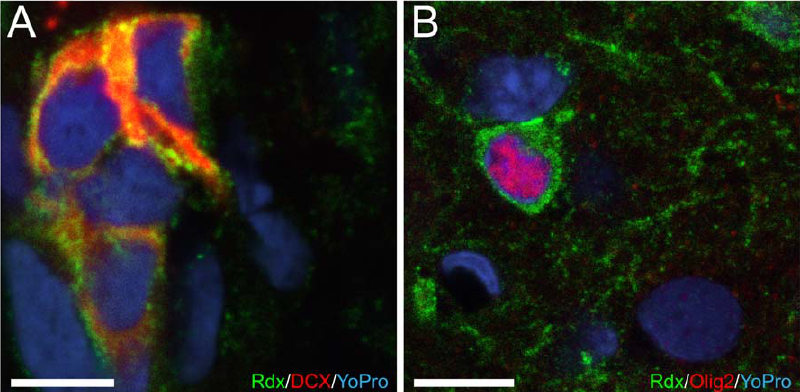
Figure 4. High magnification images of radixin + cells. Immunofluorescence staining of cells coexpressing radixin(Rdx) and doublecortin(DCX) ( A ) or radixin and Olig2 ( B ) under control conditions. In (A) Radixin(green), DCX(red), and nuclear counterstain YoPro1(blue). In (B) Radixin(green), Olig2(red), and YoPro1(blue). Scale bar in A and B=10 m m.